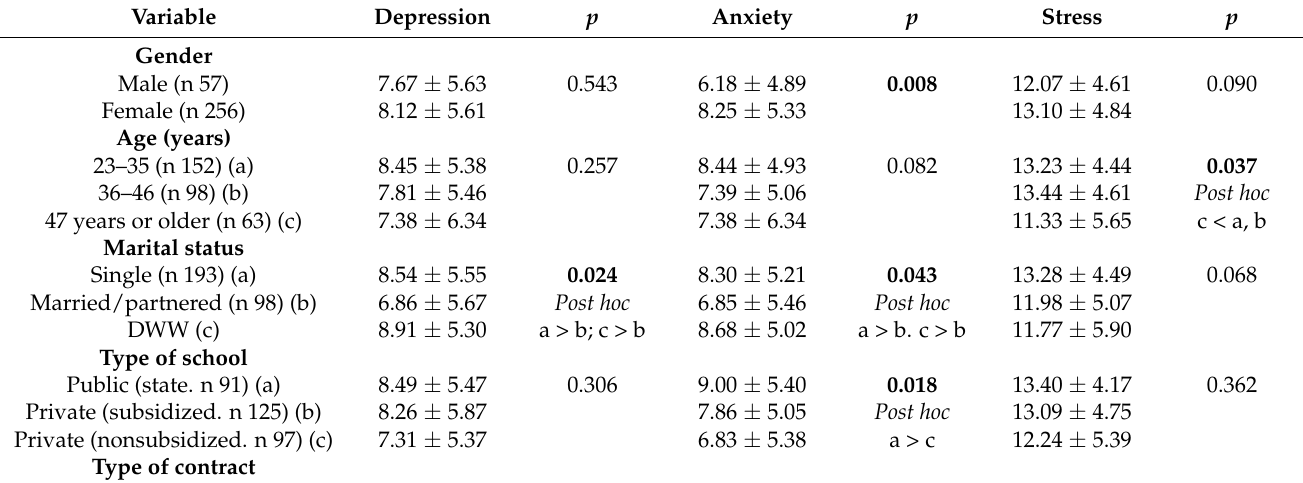
Table 2. Sociodemographic characteristics according to the dimensions of